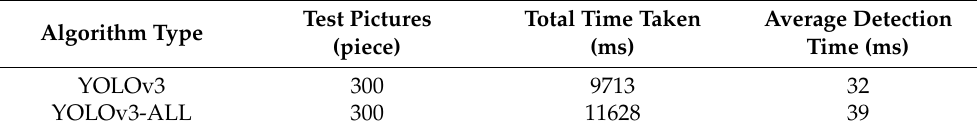
Table 7. Time comparison of detection by different